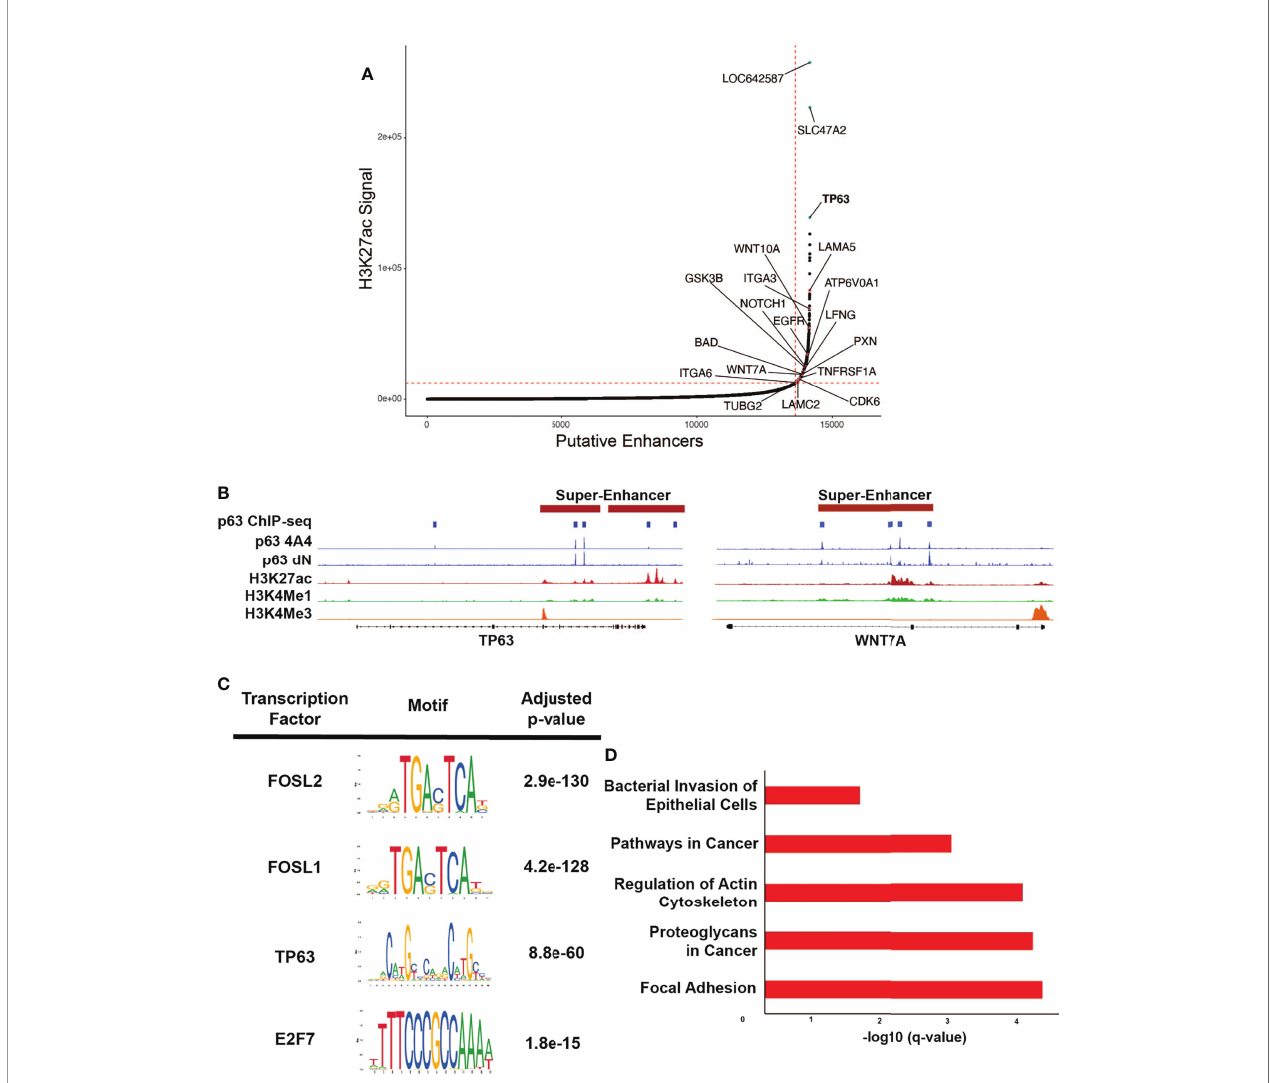
FIGURE 3 | p63 binding enriched at SEs in SCC104. (A) Hockey plot displaying the ranked H3K27Ac ChIP-seq signal in SCC104 cells. Representative genes marked by super-enhancers (SE) are shown. TP63 is highlighted in blue as one of the top SE-associated genes in SCC104. Other labeled points represent genes that have been found in previous literature to be associated with HPV infection. (B) Integrative Genomics Viewer (IGV) based representation of Histone and p63 ChIP-seq data from SCC104 cells showcasing peaks of binding around the TP63 and WNT7A loci. (C) Top enriched transcription factor motifs found in SE regions in SCC104 cells. (D) Bar graphs displaying selected top enriched KEGG pathways associated with genes identi fi ed through ROSE analysis of the SE landscape in SCC104